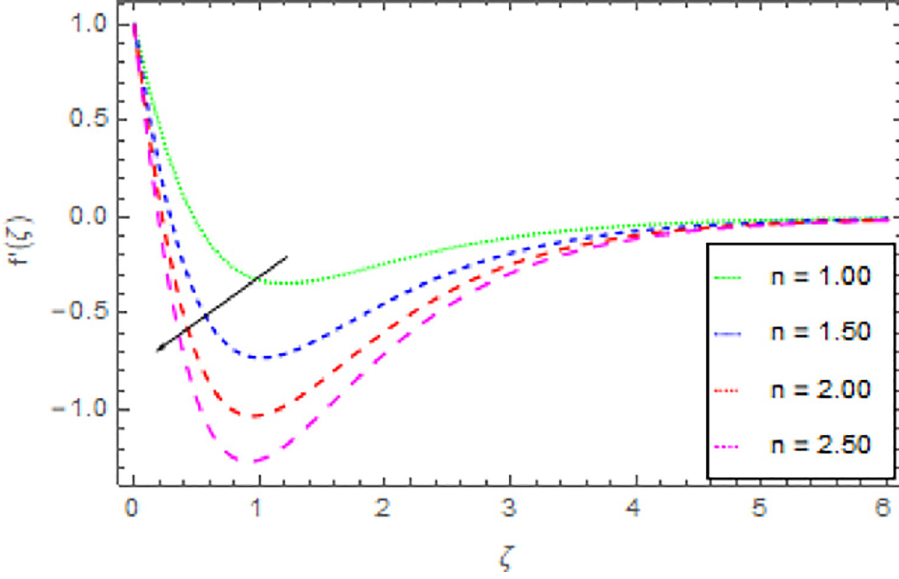
Fig 3. Deviation in nanofluid velocity ( x − direction) against n when Pr = 1000, m = 0.10, M = 2.50, δ = 0.40, β = 1.00, Nr = 0.20 and ϕ = 0.01 to ϕ =